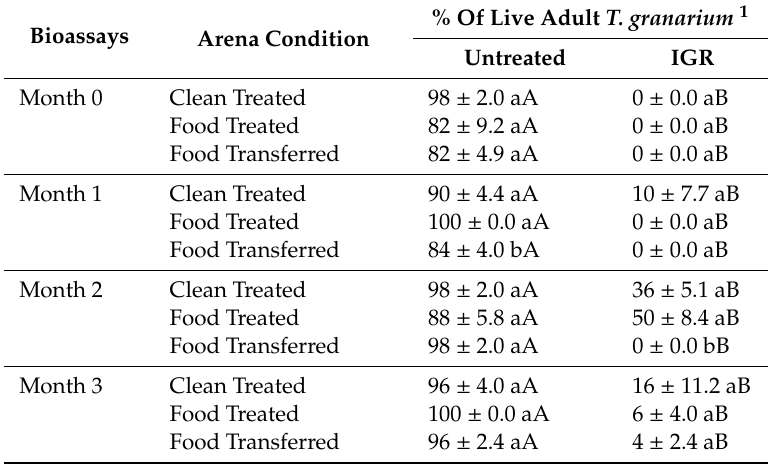
Table 9. Percentage of live adult T. granarium (means ± SE) emerging from the larvae exposed on the clean treated arenas with new food, the food-treated arenas with replaced food, and the untreated arenas with transferred treated food, as described in Table 6. Insecticide (IGR) as previously described. Bioassays conducted at one day after treatment (Month 0), or after 1, 2, and 3 months post-treatment. Adult emergence assessed 30 days after larvae were introduced onto the treated and untreated arenas.